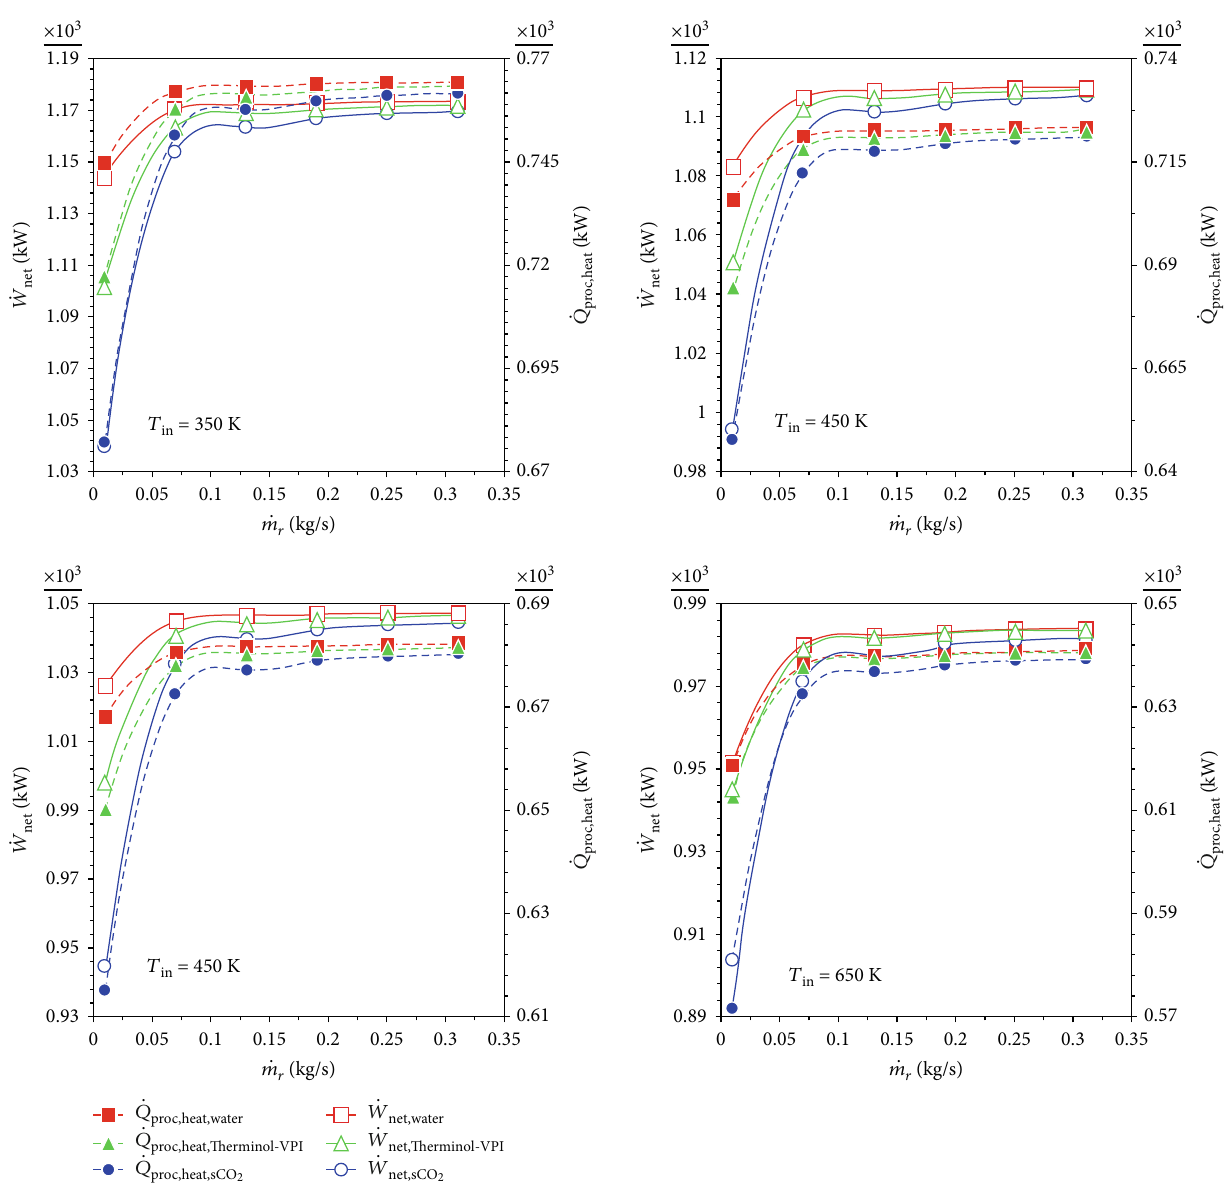
Figure 3: E ff ect of mass fl ow rate on net work and process heating for various inlet temperature